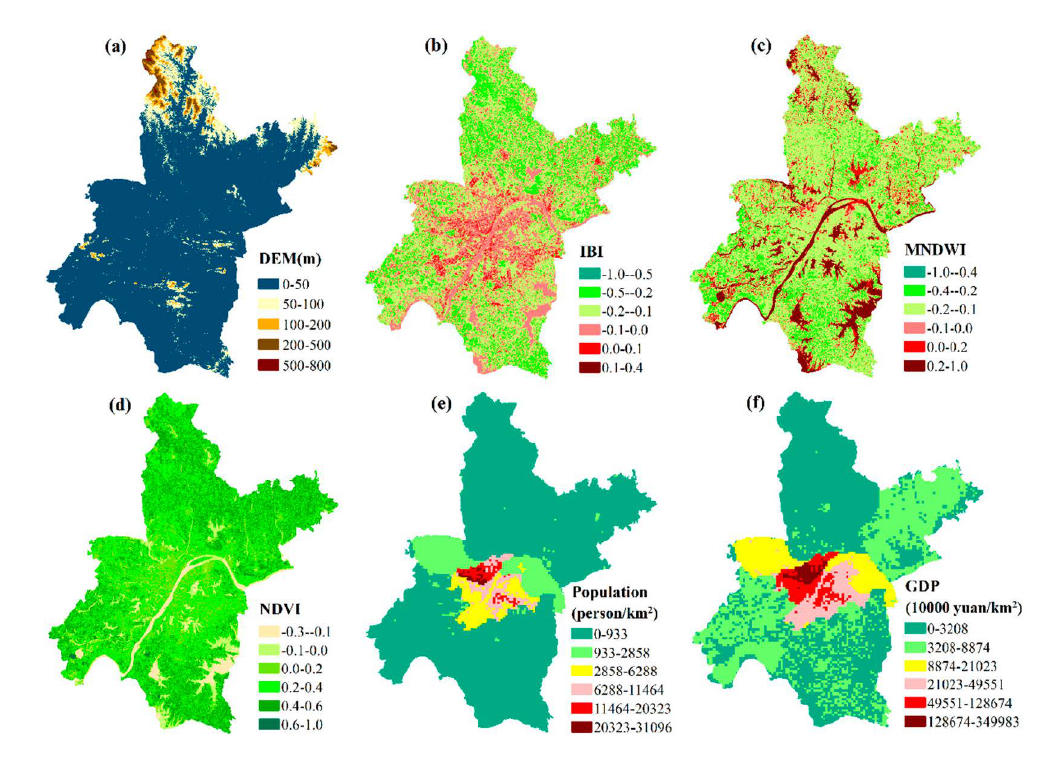
Figure 2. Spatial distribution of the driving factors of Wuhan’s LST: ( a ) DEM; ( b ) IBI; ( c ) MNDWI; ( d ) NDVI; ( e ) 1 km grid Population; ( f ) 1 km grid